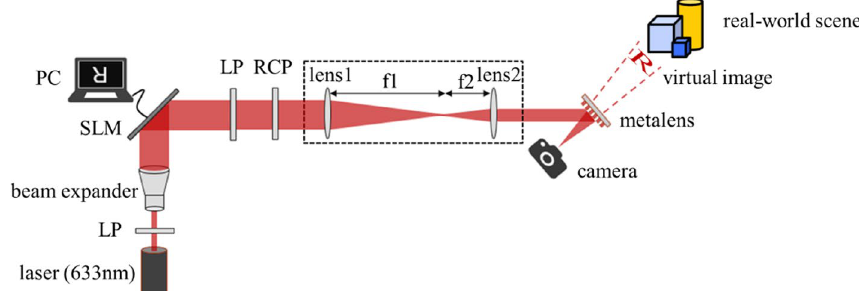
Fig. 6 Illustration of the optical setup for the AR imaging system. LP denotes a linear polarizer and RCP denotes a right‑handed circular polarizer, SLM is the spatial light modulator (Jasper Q4K70) and PC is a personal computer. A camera is used to imitate human eye. The black dashed box indicates the telescope system, which is used to downsize the virtual